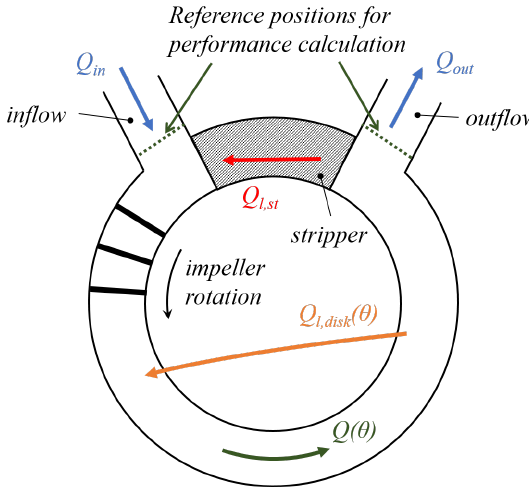
Figure 1. Scheme of the regenerative pump.